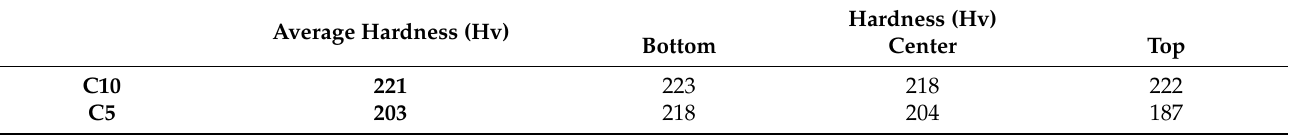
Table 3. Average hardness values and distribution with respect to the position in as-built Cr